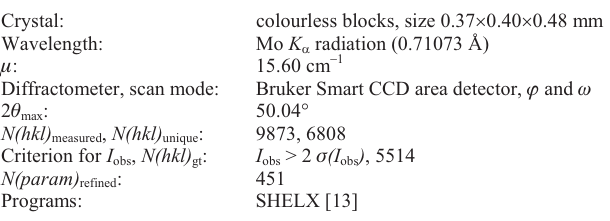
Table 2. Atomic coordinates and displacement parameters (in Å 2 )